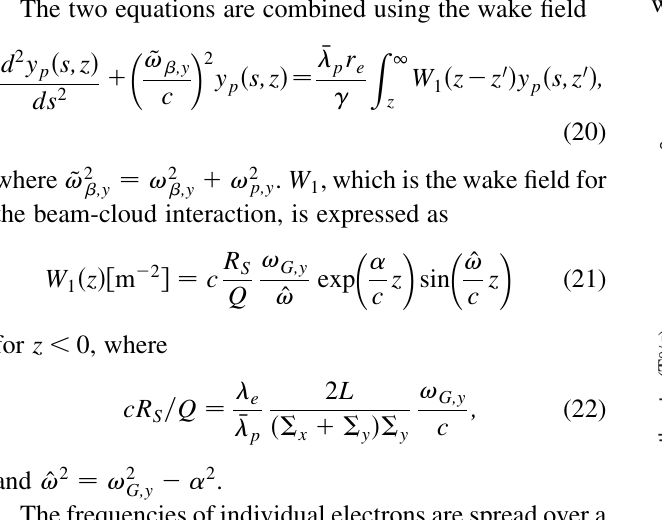
FIG. 3. (Color) Wake field (a) and growth rate [ T each coupled-bunch mode (b) given by the analytic method at KEKB (8 ns